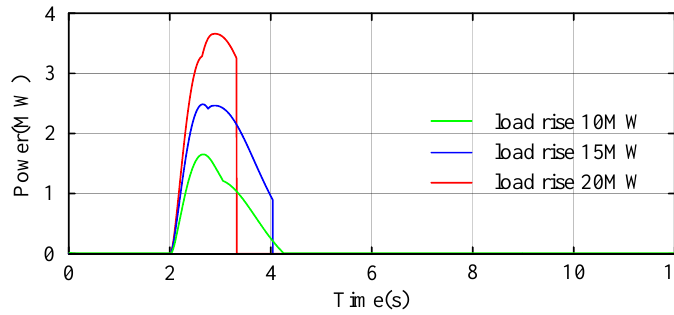
Figure 17. Operation curve of SCESS at low wind speed.